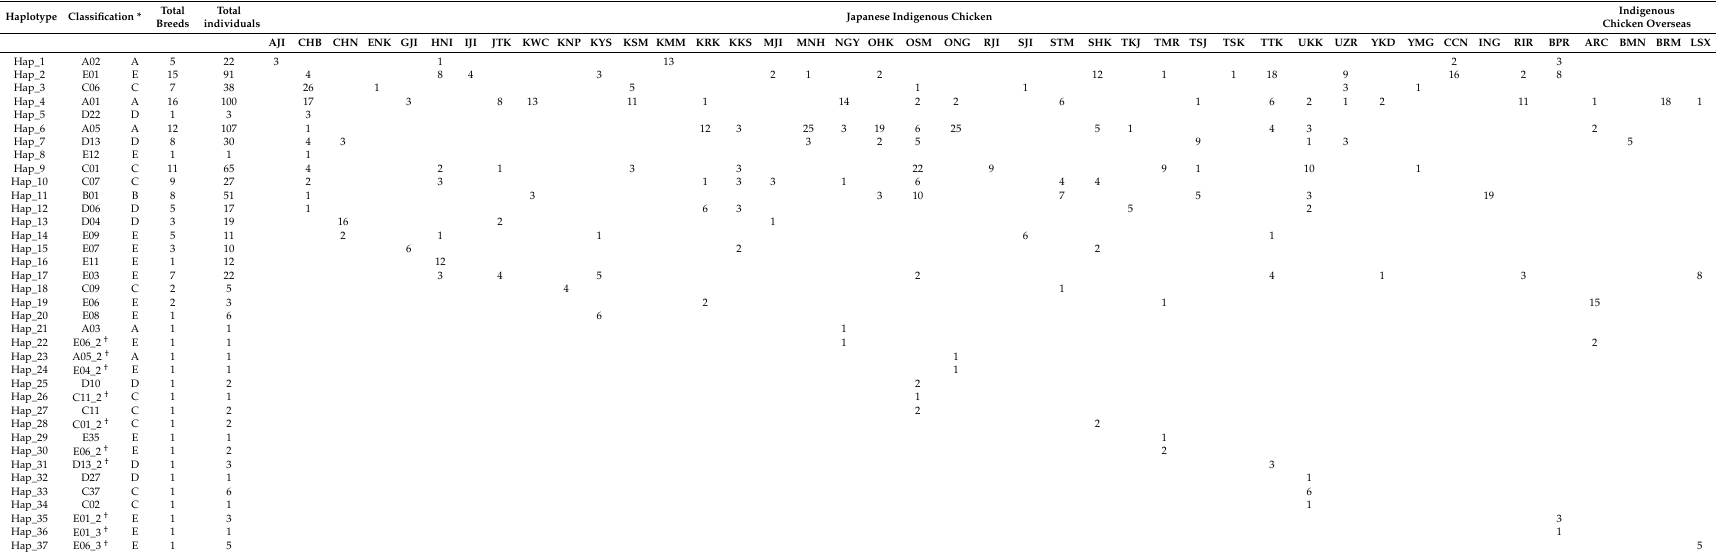
Table 2. Haplotypes of Japanese indigenous chicken breeds and chicken breeds from